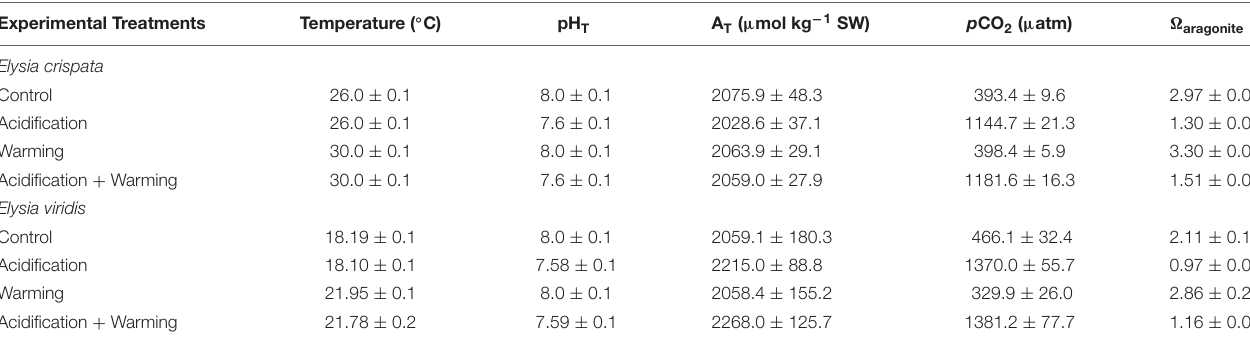
TABLE 1 | Seawater carbonate chemistry during the exposure of E. crispata and E. viridis to different temperature and pH conditions. Experimental